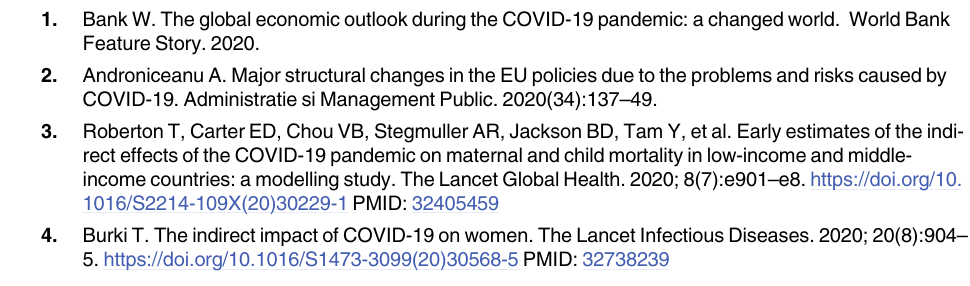
S1 Table. Preferred Reporting Items for Systematic Reviews and Meta-Analyses (PRISMA) checklist. S2 Table. The Newcastle-Ottawa scale for quality assessment of primary studies.